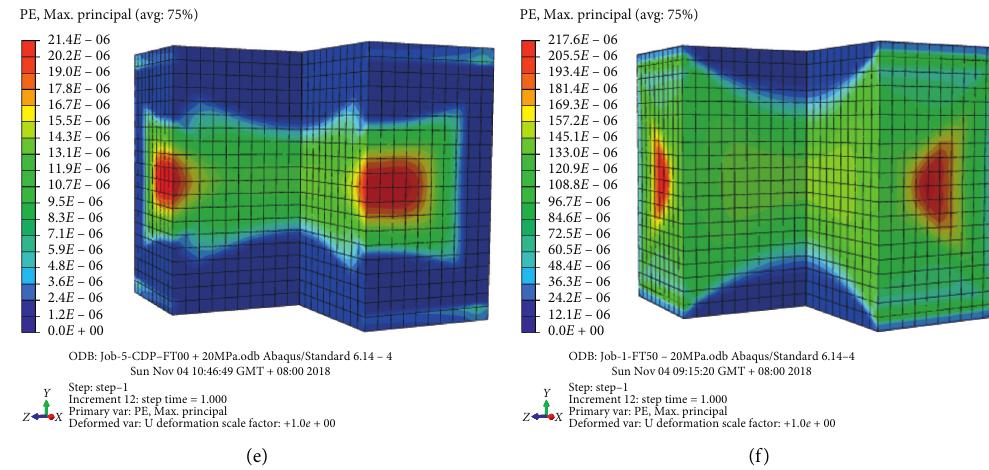
Figure 6: Stress nephograms of concrete analyzed by the CDP constitutive model: (a) vertical stress nephogram ( P � 20 MPa FTC00); (b) vertical stress nephogram ( P � 20MPa FTC50); (c) maximum principal stress nephogram ( P � 20 MPa FTC00); (d) maximum principal stress nephogram ( P � 20 MPa FTC50); (e) maximum plastic strain nephogram ( P � 20 MPa FTC00); (f) maximum plastic strain nephogram ( P � 20MPa